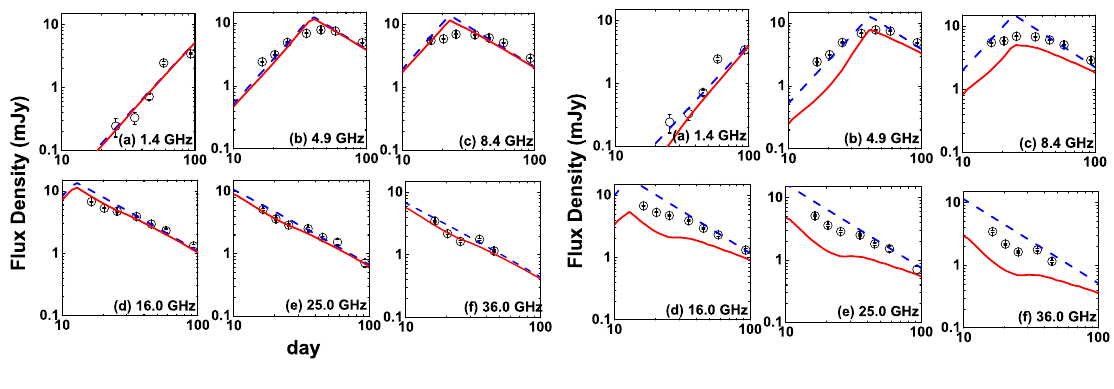
Figure 2: Left: Multi frequency radio light curves (red solid) as compared with those of SN 2011dh (Maeda, 2012). The parameters are ( A ∗ , (cid:15) e , (cid:15) B ) = (4 , 6 × 10 − 3 , 5 × 10 − 2 ) (left; adopting Model A) and (20 , 0 . 26 , 2 . 5 × 10 − 4 ) (right; Model B). The synthetic light curves without the IC cooling are also shown (blue dashed). Observational data are taken from Soderberg et al. (2012).